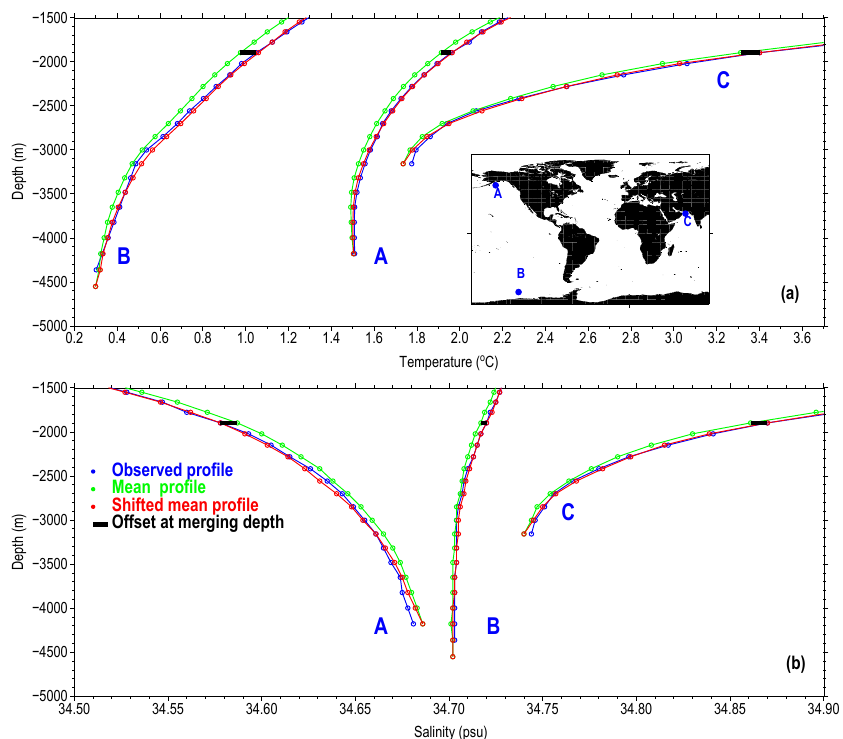
Figure 3. Example of the profile extrapolation procedure for three arbitrarily selected CTD temperature (a) and salinity (b) profiles.